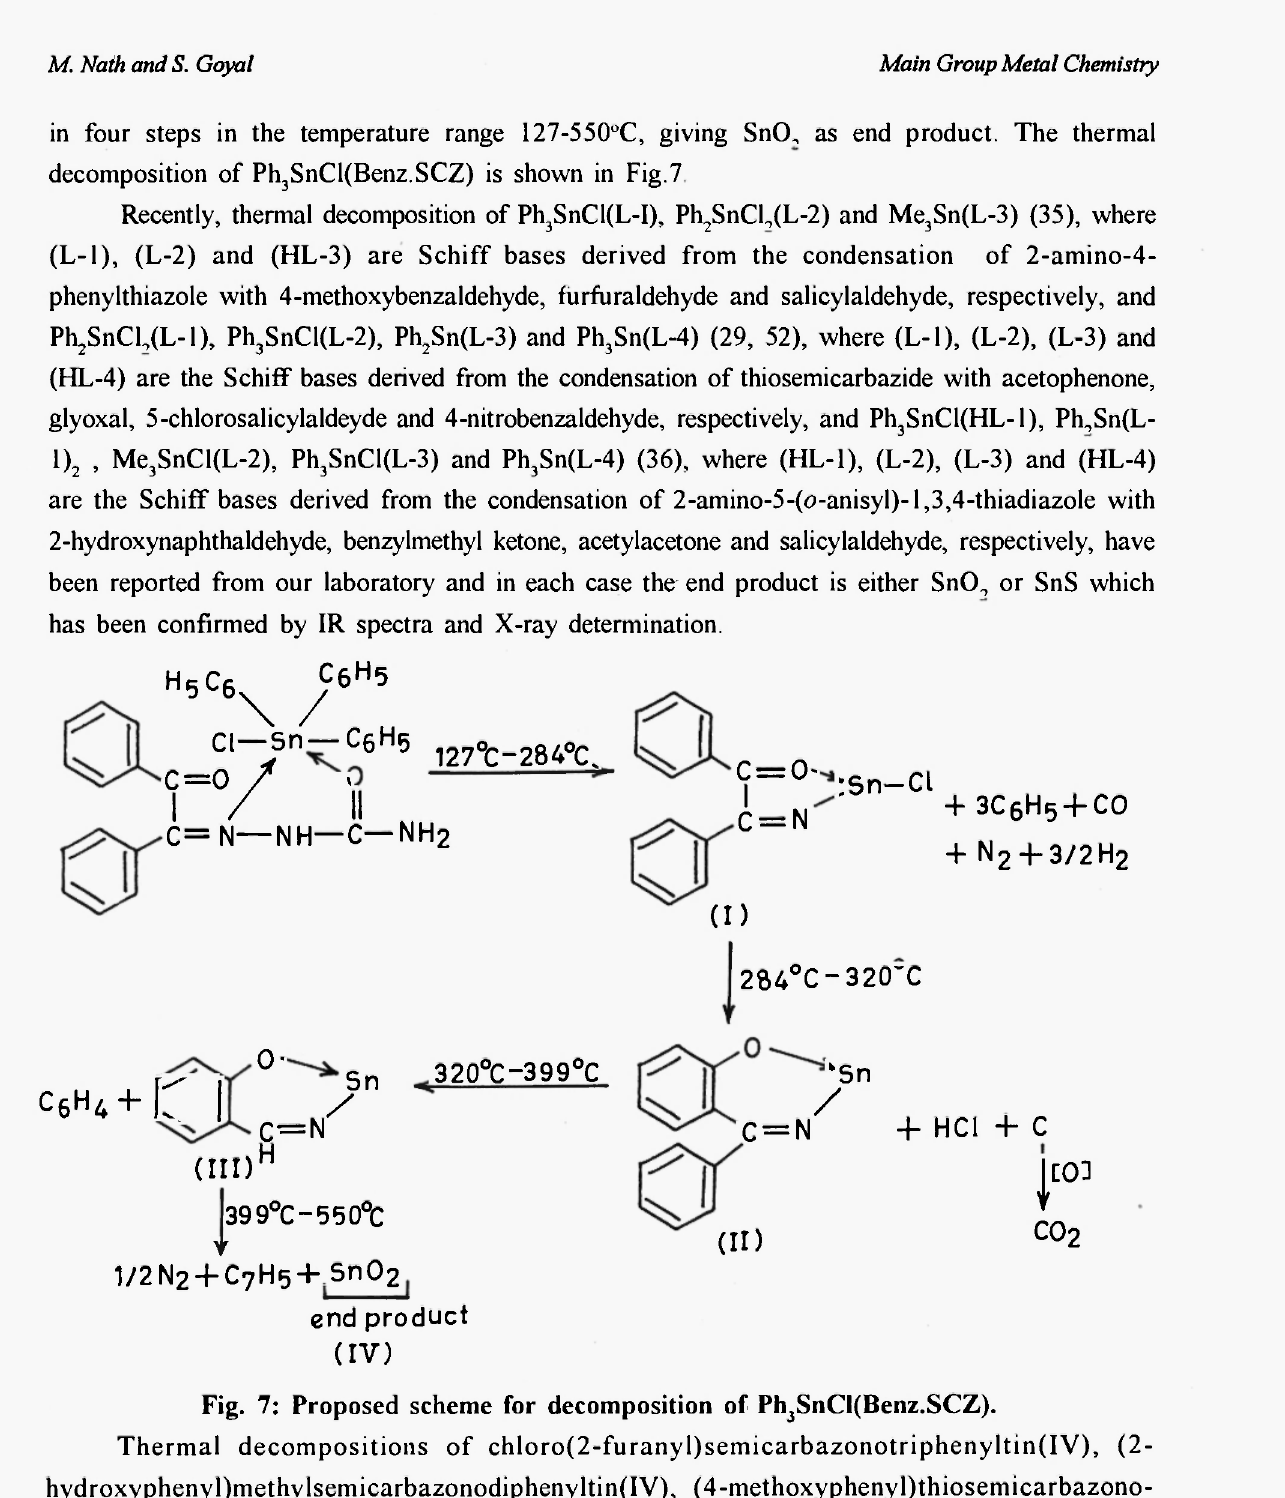
Fig. 7: Proposed scheme for decomposition of Ph 3